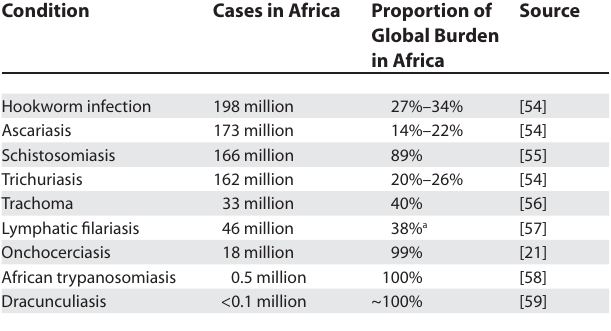
Table 1. Sub-Saharan Africa Has the Highest Prevalence of Nine Neglected Tropical Diseases